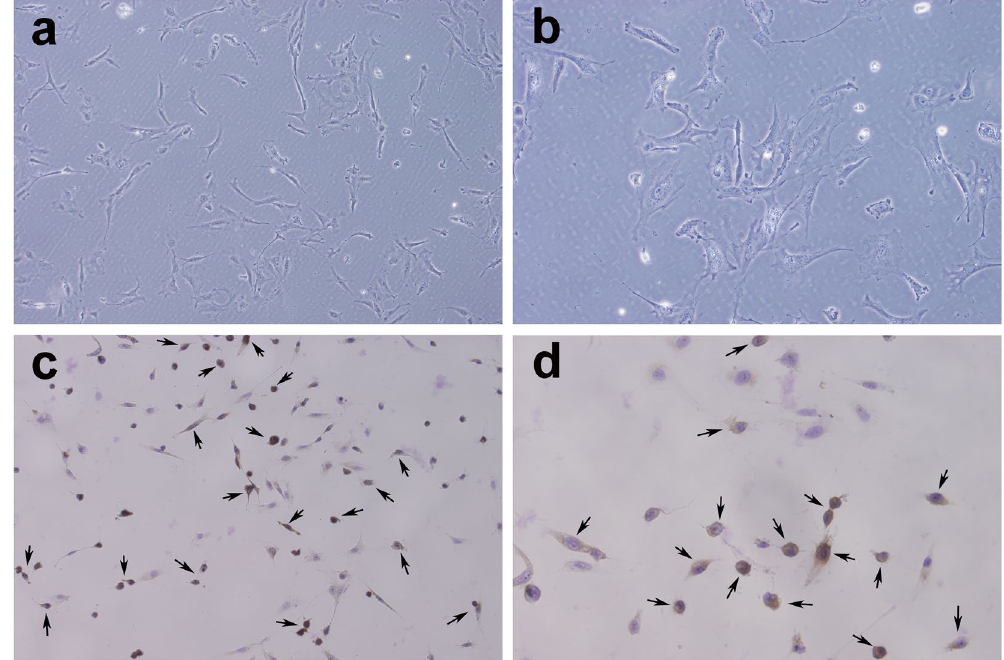
Figure 3. Typical characteristics of OGCs. ( a , b ) The OGC morphology was polygonal and fibre-like. ( c , d ) After FSHR immunostaining, a large number of adherent cells were dyed with DAB, producing a brown colour, and the dyed cells accounted for approximately 70–80% of adherent cells. Brown cells stained with DAB were OGCs. See arrows ( a and c , × 200 magnification; b and d , × 400 magnification); n =